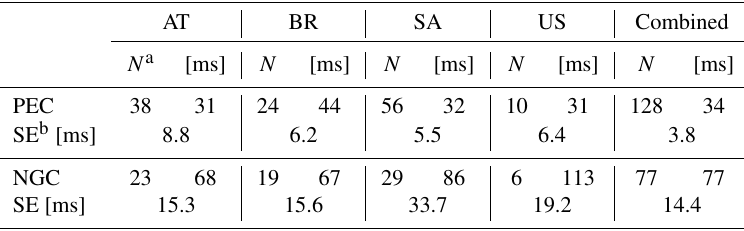
Table 2. Statistics for interstroke time intervals that precede subsequent PEC and NGC. AT BR SA US All N a GM [ms] N GM [ms] N GM [ms] N SE b [ms] (cid:49)T NGC a N is sample size. b SE is standard error. Table 3. Interstroke time interval between strokes using a PEC and interstroke time interval preceding an NGC after two or more strokes down the same lightning channel. AT